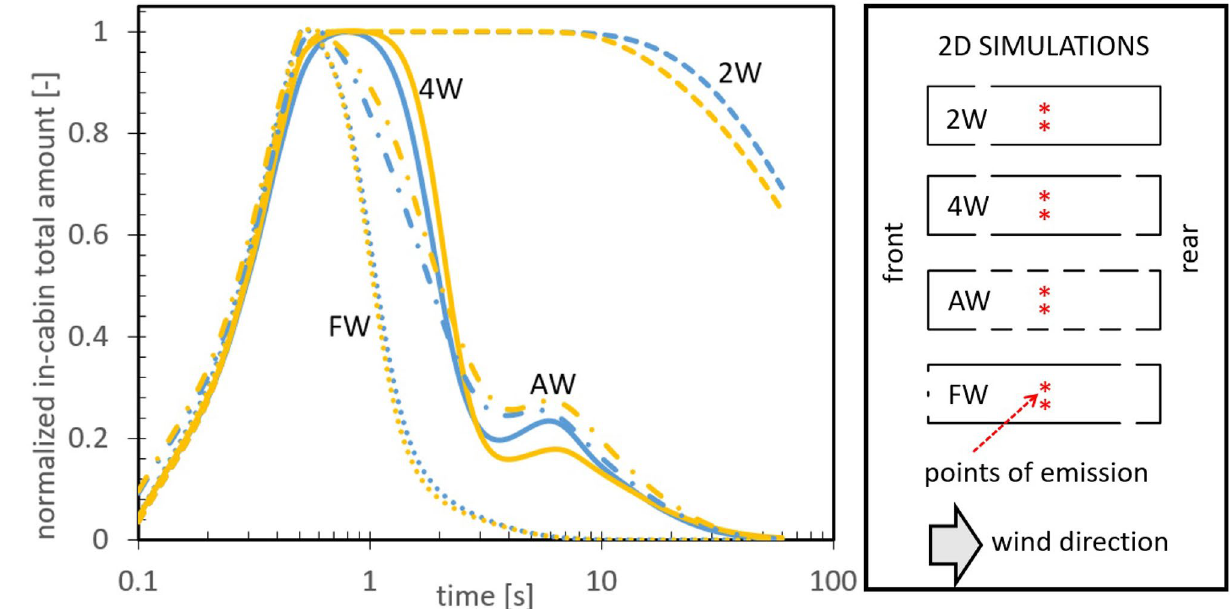
Figure 2. 2D simulations: total amount of aerosols inside the bus as a function of time, normalized with the ε model while yellow lines correspond corresponding maximum values. Blue lines are the results using the κ − ω model. The explanation of the different open windows configurations are explained in the to the SST κ − text and in the scheme at the right side. Aerosol emission occurs in the first 0.5 seconds at the center of the bus cabin. See also the movies included in the supplementary material. The local increments observed around the 6s in the AW and 4W cases indicate re-entry of aerosols promoted by the circulating currents formed outside the bus; i.e. part of the aerosols that left the bus at the frontal-lateral windows can return through the back-lateral windows.